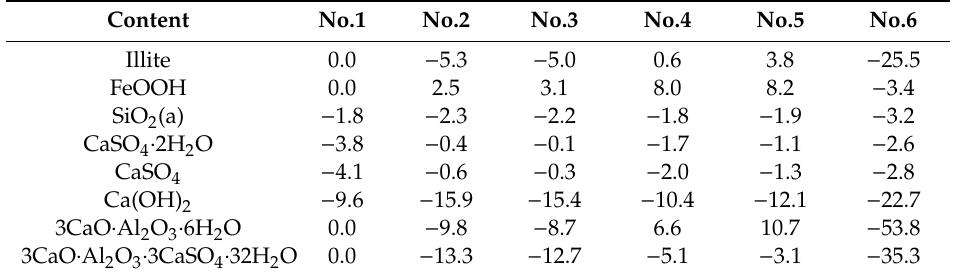
Table 3. The calculated saturation index of minerals in the water of the laboratory immersion tests.